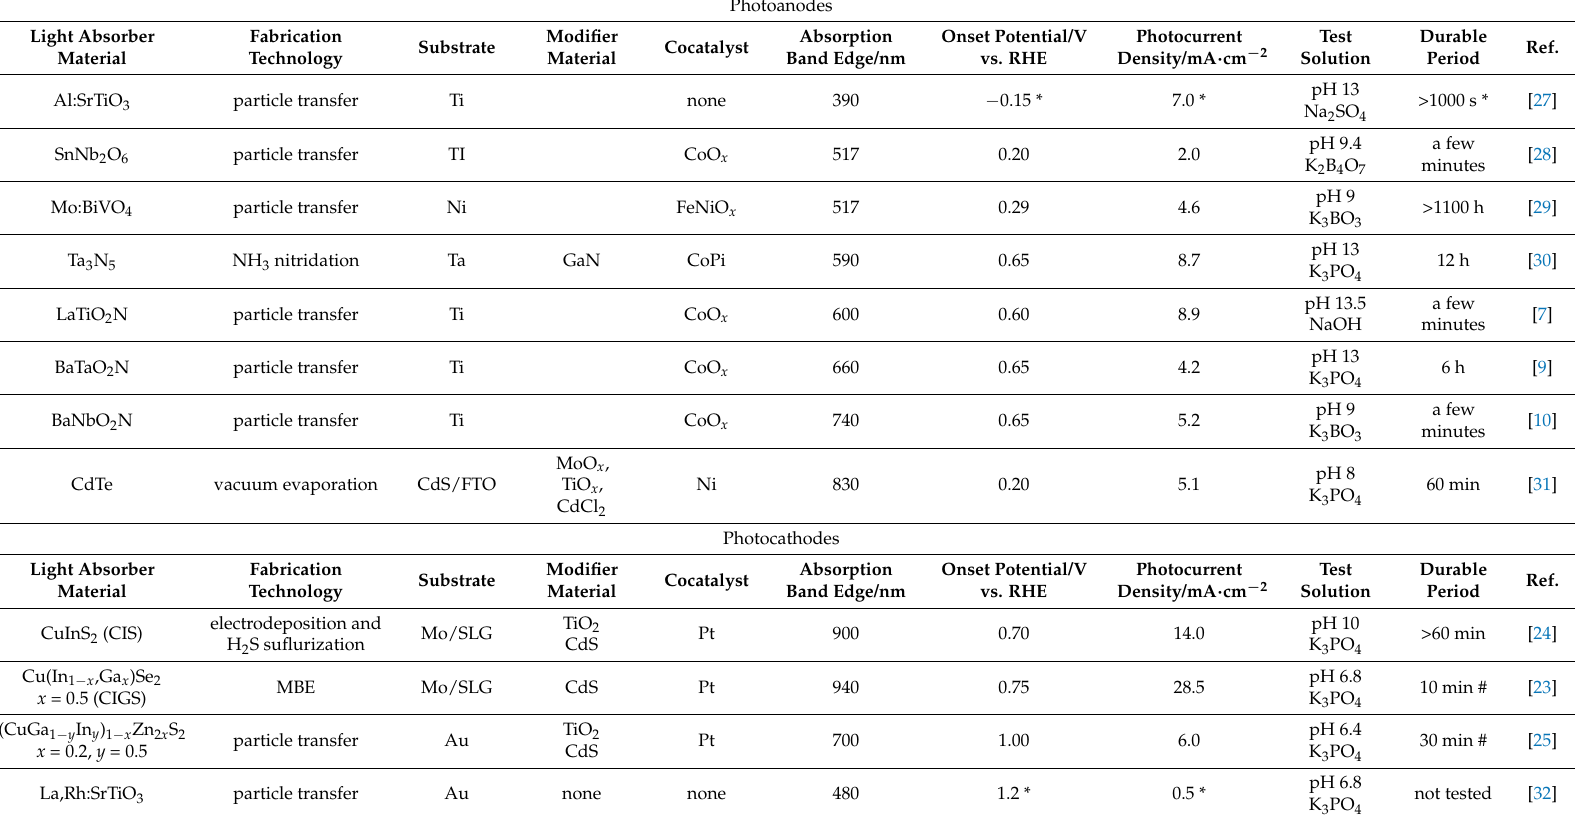
Table 1. ARPChem score board for photoanode and photocathode materials. The performing parameters (photocurrent density, onset potential and durable period) were all experimentally obtained within ARPChem and published in literature previously. The tests were conducted with solar simulator 1 kW · m − 2 AM 1.5 G irradiation (Those marked with * were tested by 300 W Xe lamp and a λ > 420 nm filter, which is approximately 3 times more intense than solar simulator, with a similar spectrum.). The durable period is defined as the time for the photocurrent density to reach 80% of the initial value. The photocurrent density, the onset potential, and the durable period were measured at an electrode potential of 0 V vs. RHE for all photocathodes (that is, the potential of H 2 evolution), and 1.23 V vs. RHE for all photocathodes (that is, the potential of O 2 evolution). For photocathode durability tests, the data marked with # were recorded at 0.6 V vs. RHE, which is the median potential of 0 V and 1.23 V vs. RHE, representing the practical operation crossover potential of the dual-electrode cell.